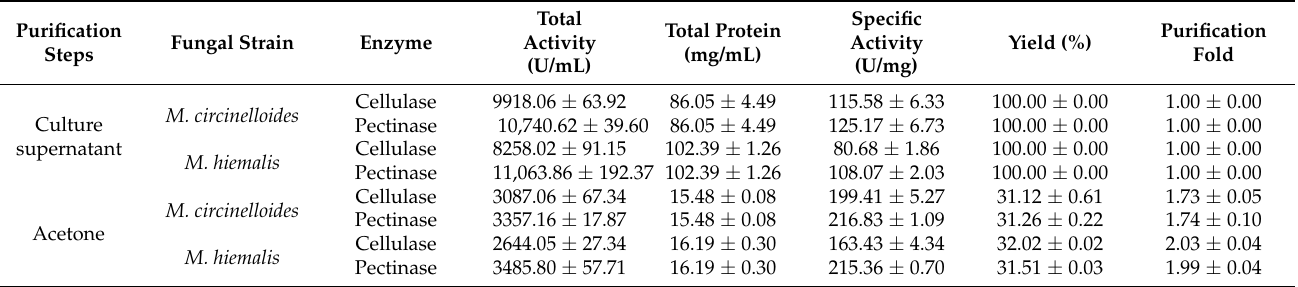
Table 9. Summary of specific activity, yield and purification fold of cellulase and pectinase produced by M. circinelloides and M. hiemalis